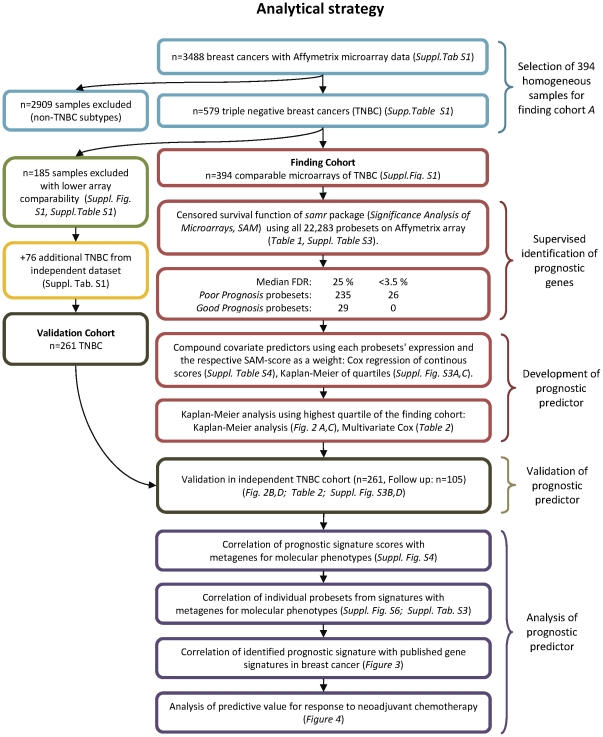
Development and validation of prognostic predictors according to REMARK criteria (McShane et al. J Clin Oncol. 2005;23:9067).The outline of the analysis strategy is schematically shown. The upper part shows the selection of the homogenous sample cohort of 394 TNBC. The middle part shows the identification of prognostic genes for TNBC, the development of the prognostic predictor, and the validation of this gene signature. The lower part displays the analysis of the genes which make up the signature regarding their relationship to previous known molecular factors among TNBC.